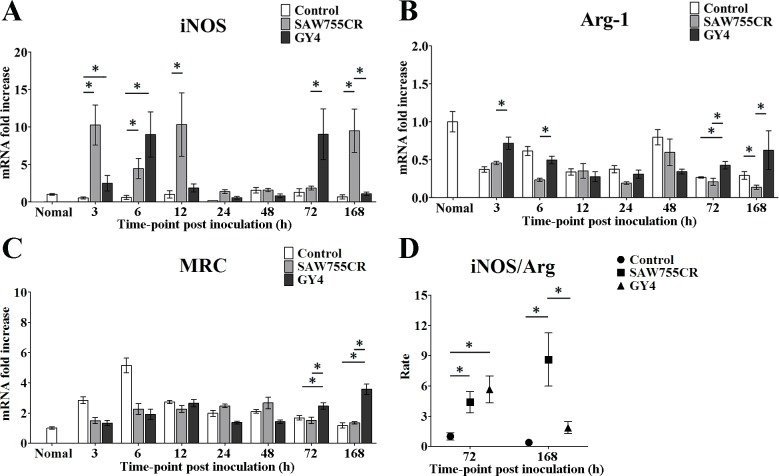
Quantitative real-time PCR assays of expression of iNOS (A), Arg-1 (B) and MRC-I (C) and iNOS/Arg-1 mRNA ratio (D) in ALAs in hamsters. Expression levels of cytokine genes in liver tissues from hamsters inoculated with culture medium, 1×106
E. histolytica SAW755CR strain or E. nuttalli GY4 strain trophozoites are shown as 2-ΔΔCt of the target gene relative to β-actin and normalized with the corresponding values in normal hamster. Y axes in A to C are numbers correspond to the fold increase over 1.0, assigned to normal hamster. The iNOS/Arg-1 mRNA ratio in hamsters inoculated with trophozoites of E. histolytica SAW755CR or E. nuttalli GY4 is compared with that in controls at 72 h and 168 h post-inoculation. Error bars are standard errors of the mean calculated from three independent replicates. The abscissa shows the time post-inoculation. * P < 0.05.